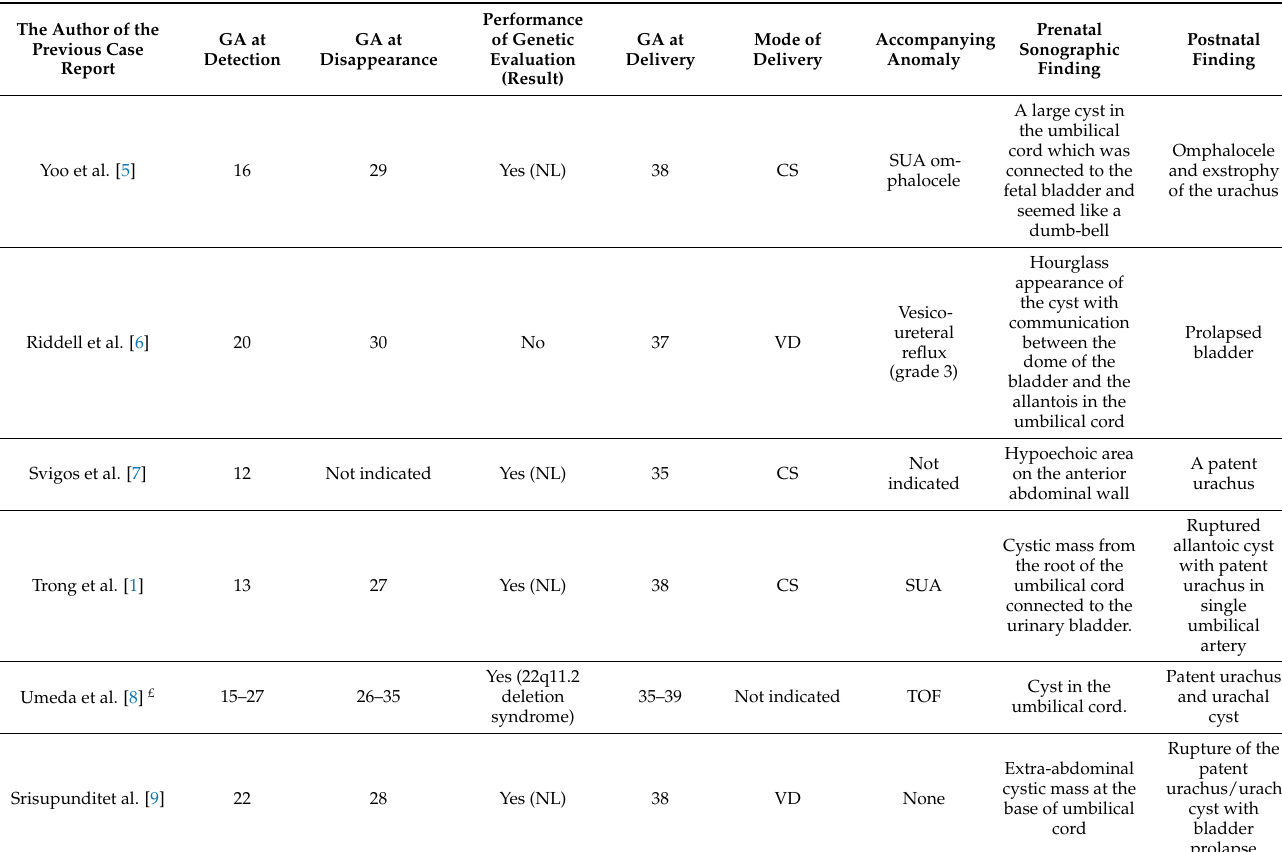
Table 1. A brief review of similar